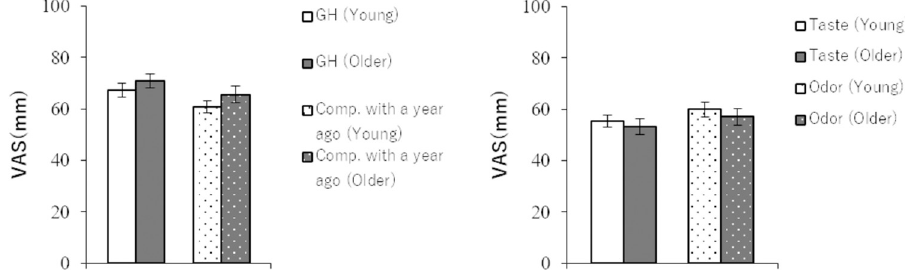
Fig 1. a. Subjective current status of general health and comparison with the previous year. Error bars are 95% confidence intervals. b. Subjective current sensitivity of taste and olfaction. Error bars are 95% confidence intervals.